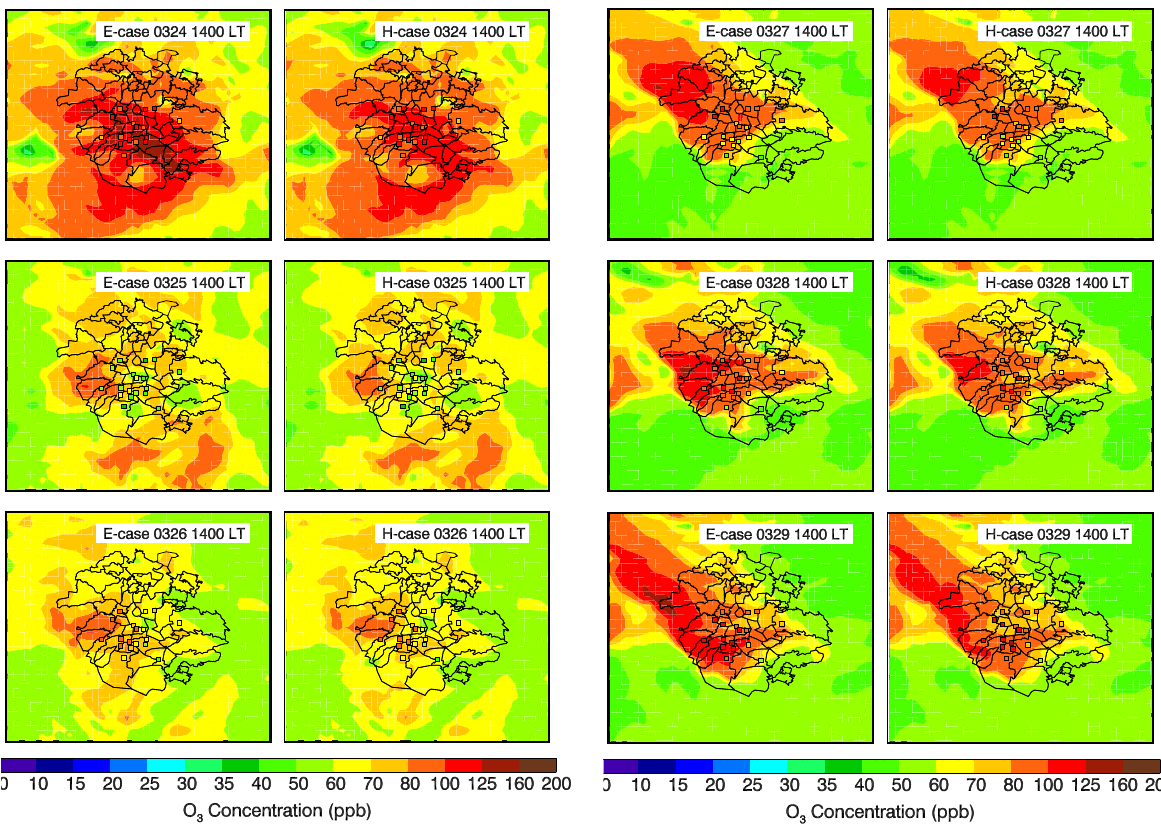
Fig. 9. Pattern comparison of simulated vs. observed O 3 at 14:00LT over Mexico City in the E-case (left) and H-case (right) during the 24–29 March 2006. Colored dots: observations; color contour: